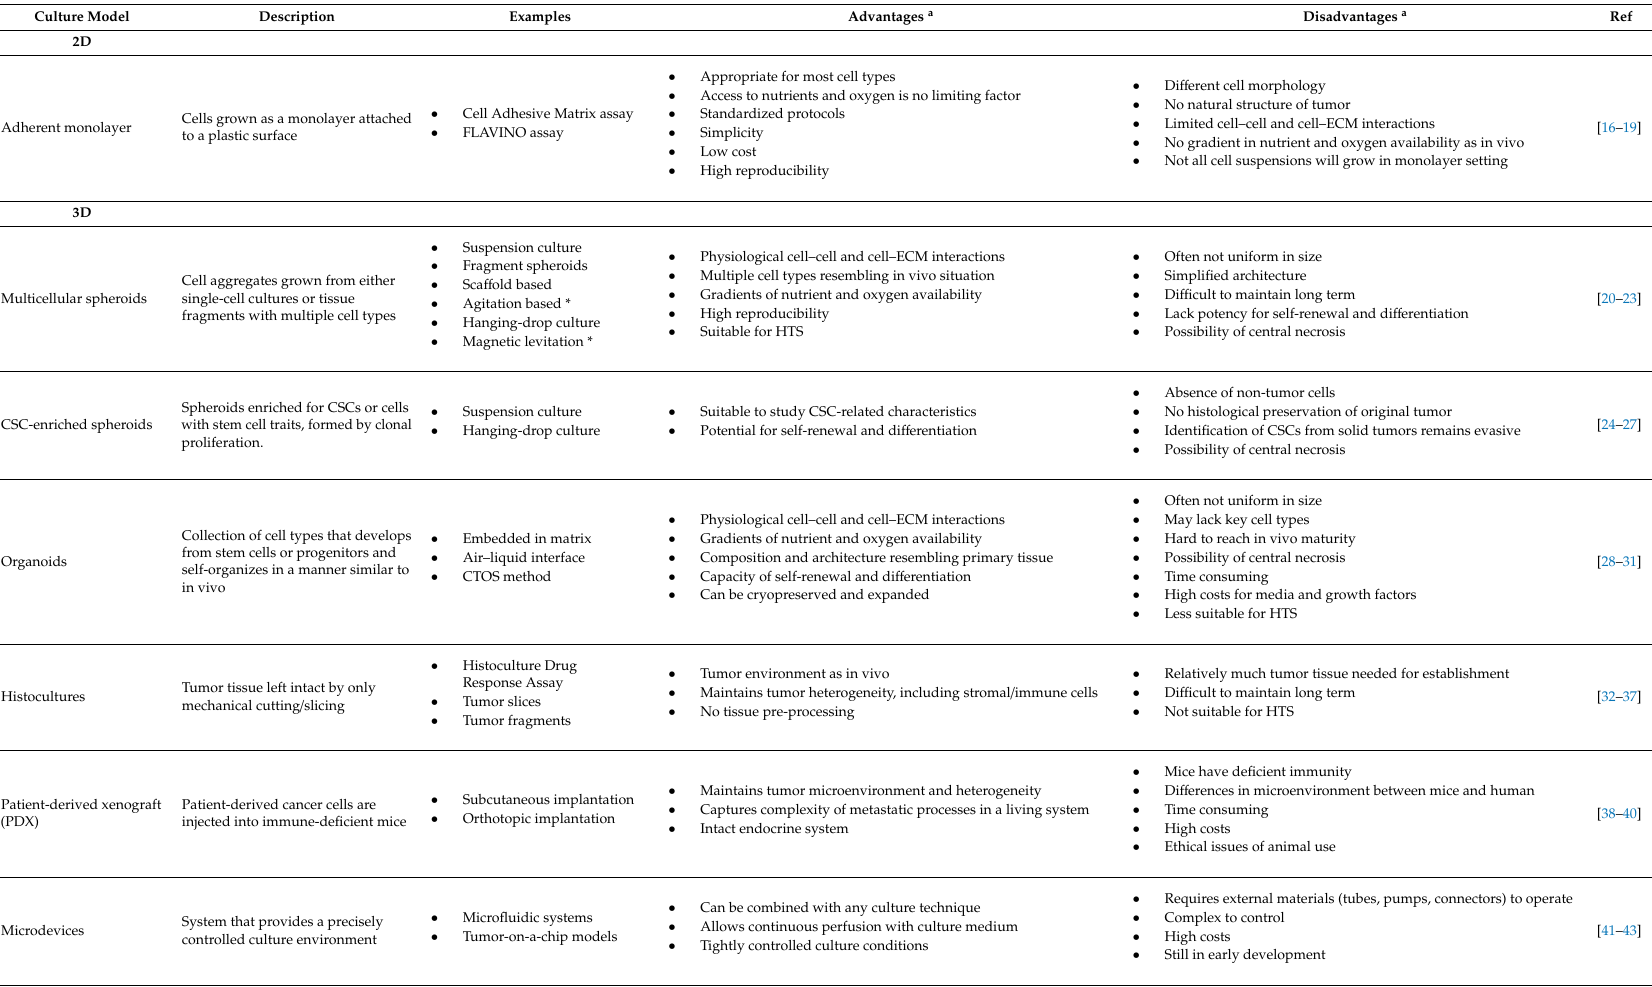
Table 2. Overview of currently used primary culture models for